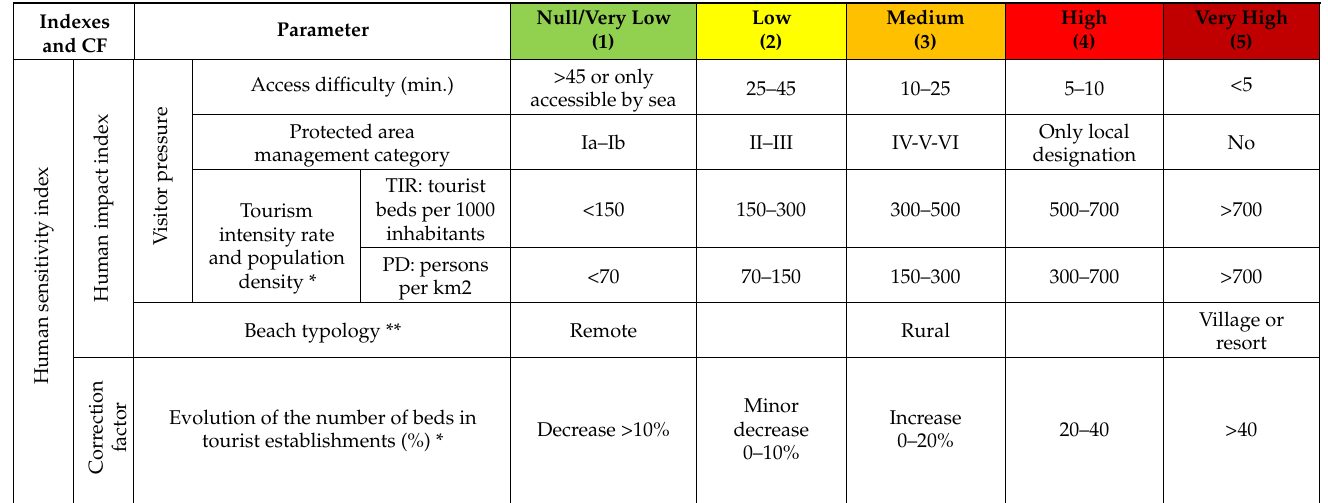
Table 3. Parameters and correction factor used to assess the human sensitivity index (CSSI